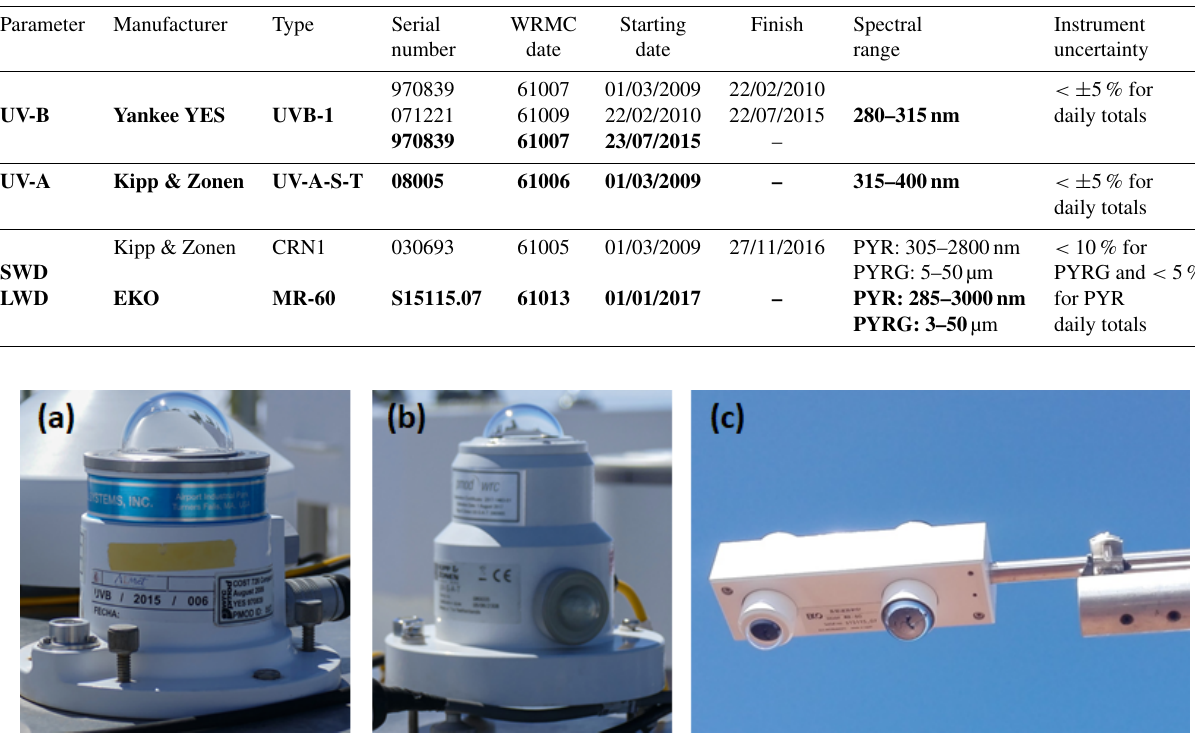
Figure 3. Extended-BSRN radiation instruments currently in operation at IZA BSRN. (a) UV-B: Yankee YES pyranometer; (b) UV-A: Kipp & Zonen UV-A-S-T pyranometer; and (c) SWU and LWU: EKO M-60 net radiation